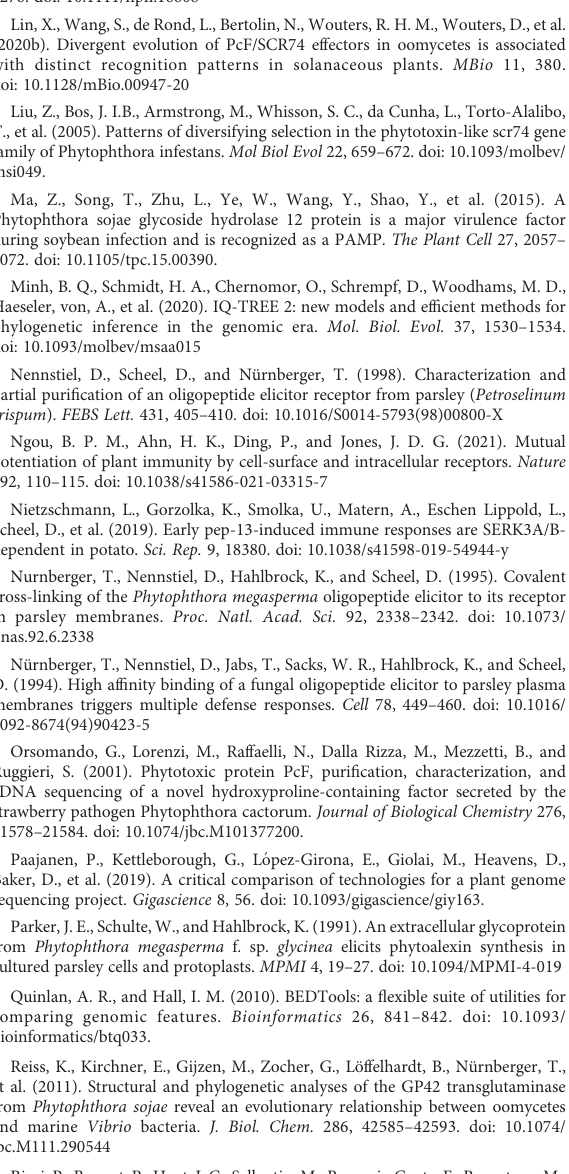
The Pep-13 peptides are highlighted by cyan (PDB: 3TW5). (B) Alignment of Pep-13 and Pep-25 peptides from 8 Phytophthora species. SUPPLEMENTARY FIGURE 2 Phylogeny of potato LRR-RLKs and the candidate proteins The kinase domains of 365 potato RLK proteins, 12 candidate RLK proteins from GIG362-6 and 21 known RLK proteins were included (blue). I3 from tomato was used as an outgroup The candidate RLK proteins from Solanum microdontum subsp. gigantophyllum are highlighted by red. The scale bar indicates the number of amino acid substitutions per site.